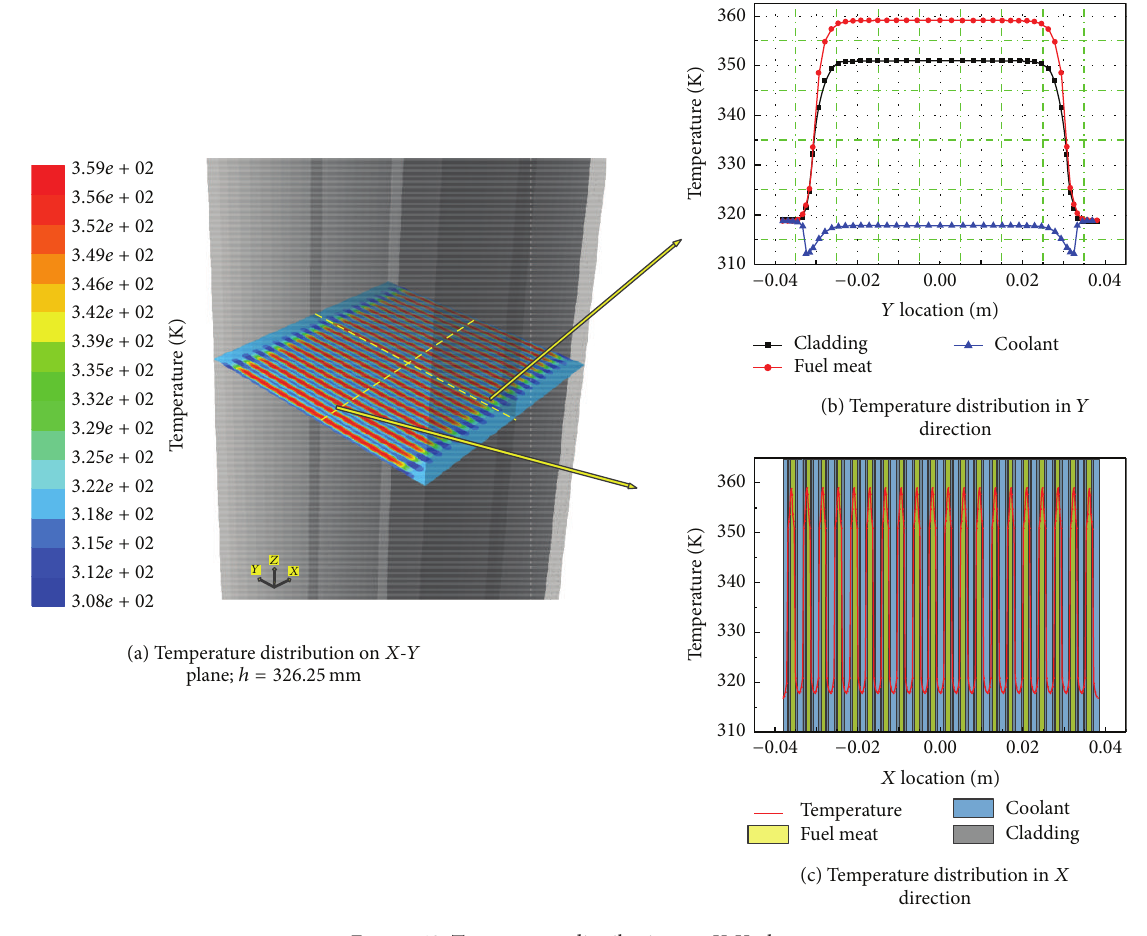
Figure 10: Temperature distribution on 𝑋 - 𝑌 plane.